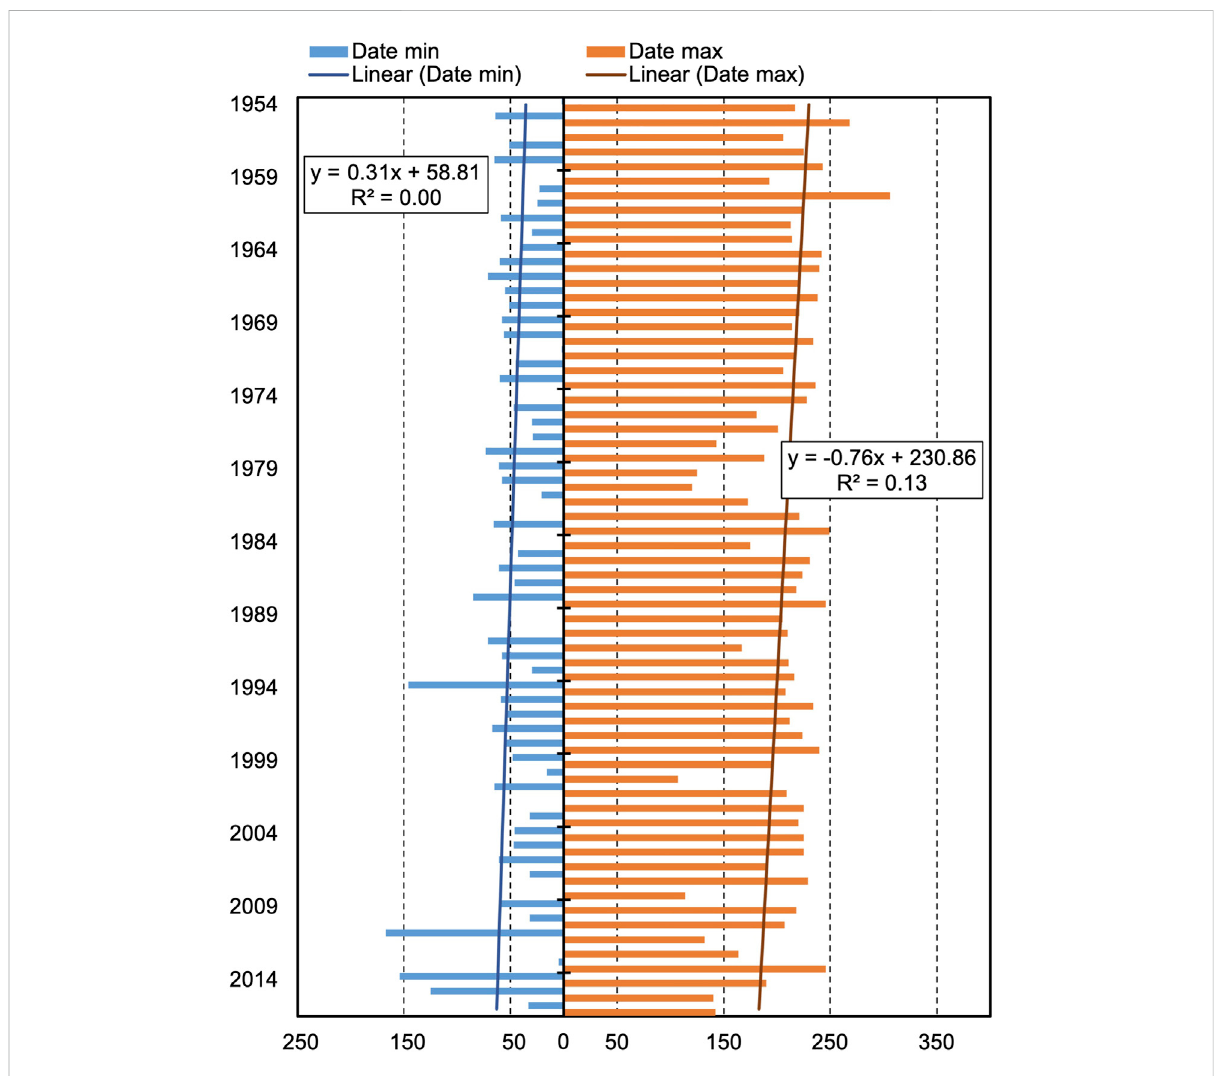
FIGURE 6 Temporal variation of extreme daily values from 1954 to 2016 ( p <